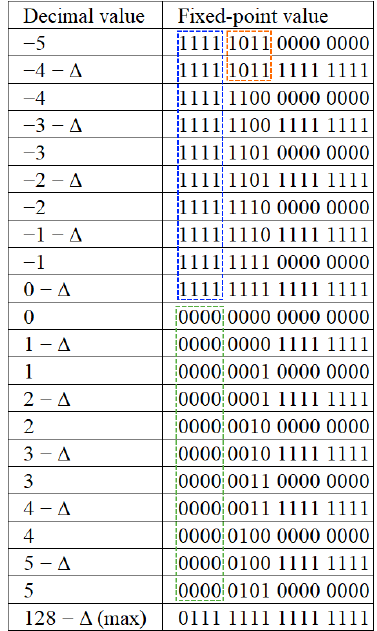
Figure 12. Approximation nodes. Dotted boxes indicate the bits used in Equations (2) (blue box), (3) (green box) and (4) (orange